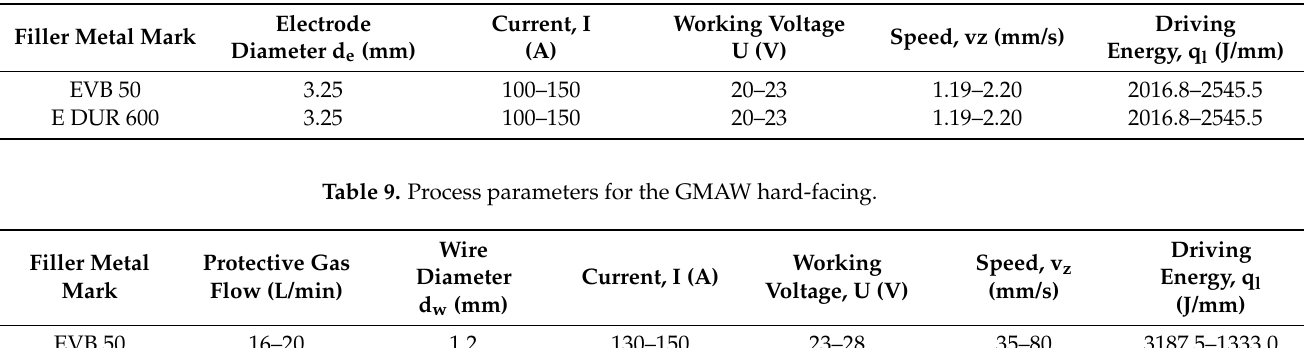
Table 8. Process parameters for the MMAW hard-facing.